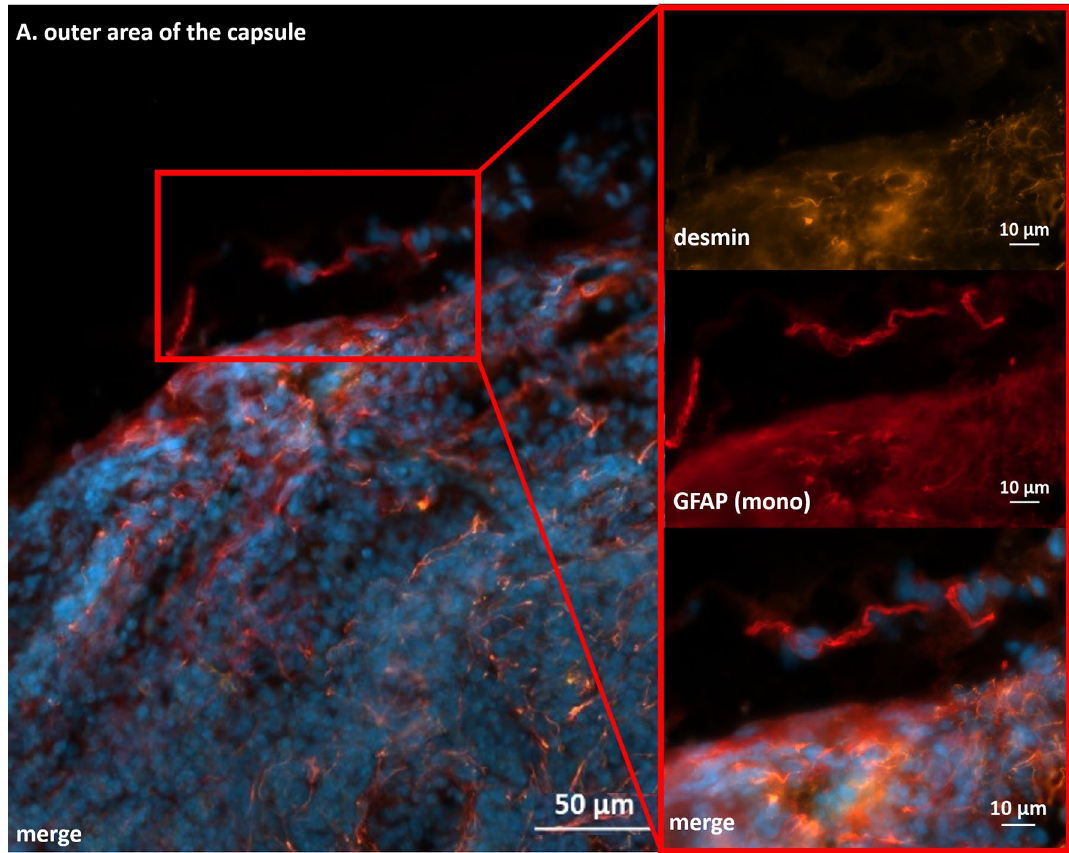
Figure 8. Immunhistochemical staining of cervical lymph node with monoclonal anti-GFAP antibody (red) and desmin (orange). DAPI for nuclear staining in blue. GFAP positive structures with typical morphology can be found in the outer area of the capsule of the lymph node. These structures show no staining for desmin.